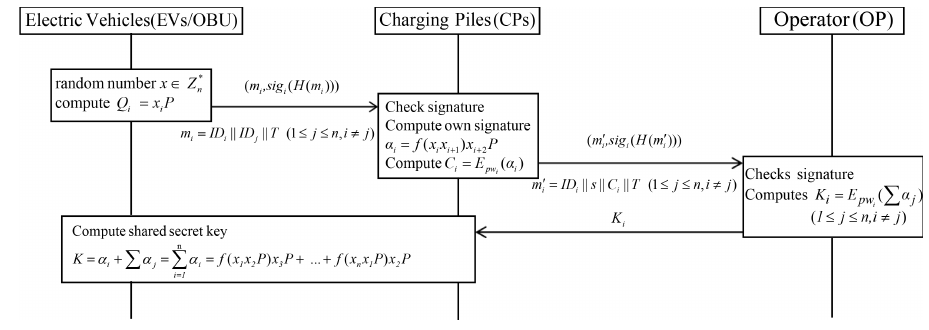
Figure 2. Registration phase of Huang et al.’s scheme.